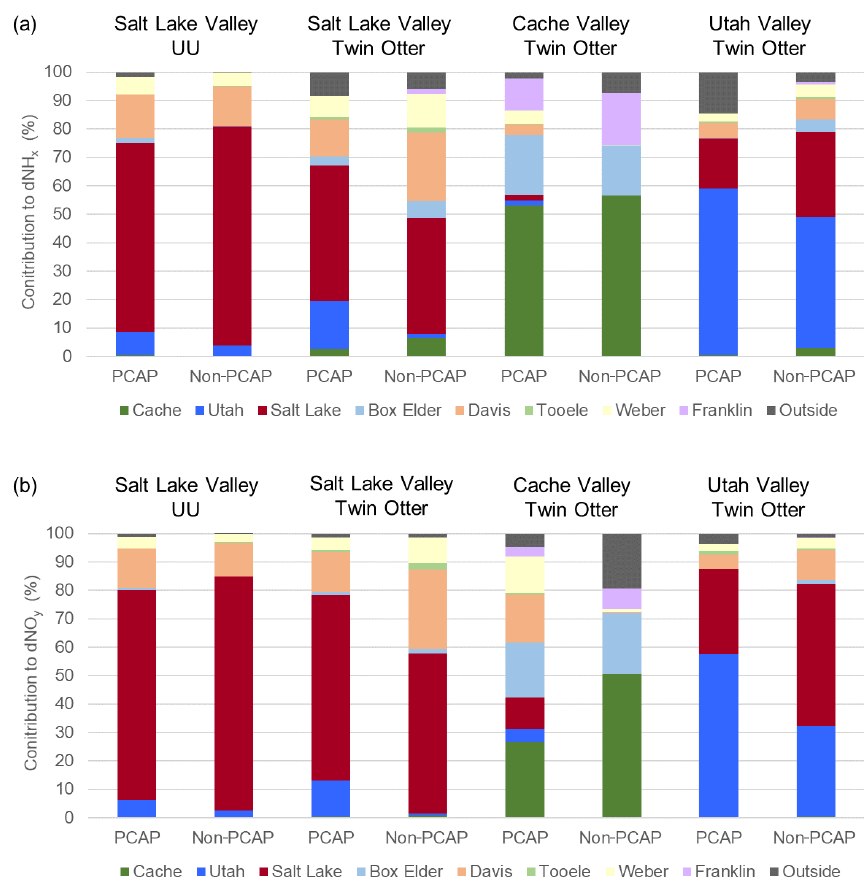
Figure 8. Inter-valley exchange of pollutants: contributions from different counties to (a) dNH x and (b) dNO y at the UU (Salt Lake Valley) site and Twin Otter locations in Salt Lake Valley, Cache Valley and Utah Valley. The inter-valley exchange was evaluated by segregating contributions from the footprint model (see contributions map in Fig. 5) into counties of origin for each run of the footprint model (i.e. every 2min of Twin Otter flight path and every hour for the UU